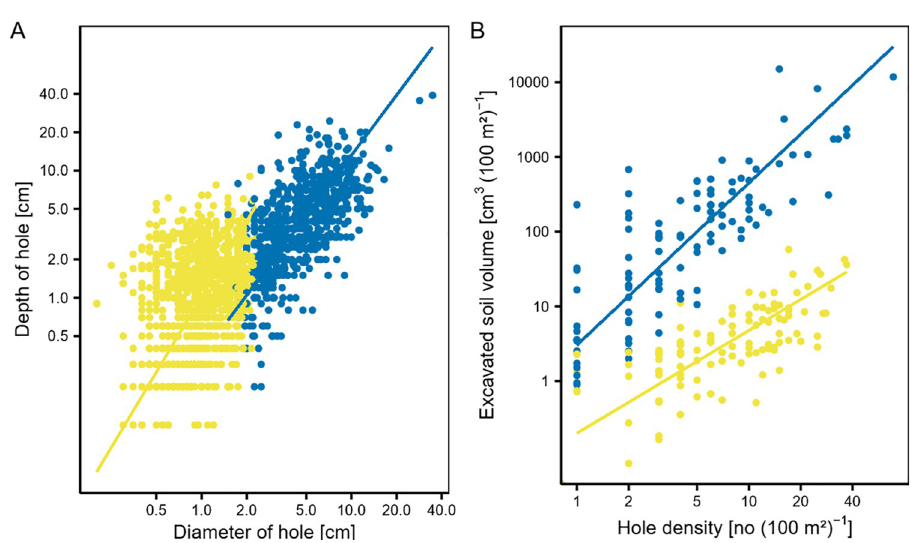
Fig 1. Relationships between burrow parameters and bioturbation parameters created by burrowing invertebrates (yellow) and vertebrates (blue). (A) Relationship between the depth and mean diameter of the holes, (B) relationship between the excavated soil volume and hole density. The regression lines are derived from the reduced major axis analysis. Note that both axes in (A) and (B) were log 10 -scaled. Data from both field campaigns and all sites were used.